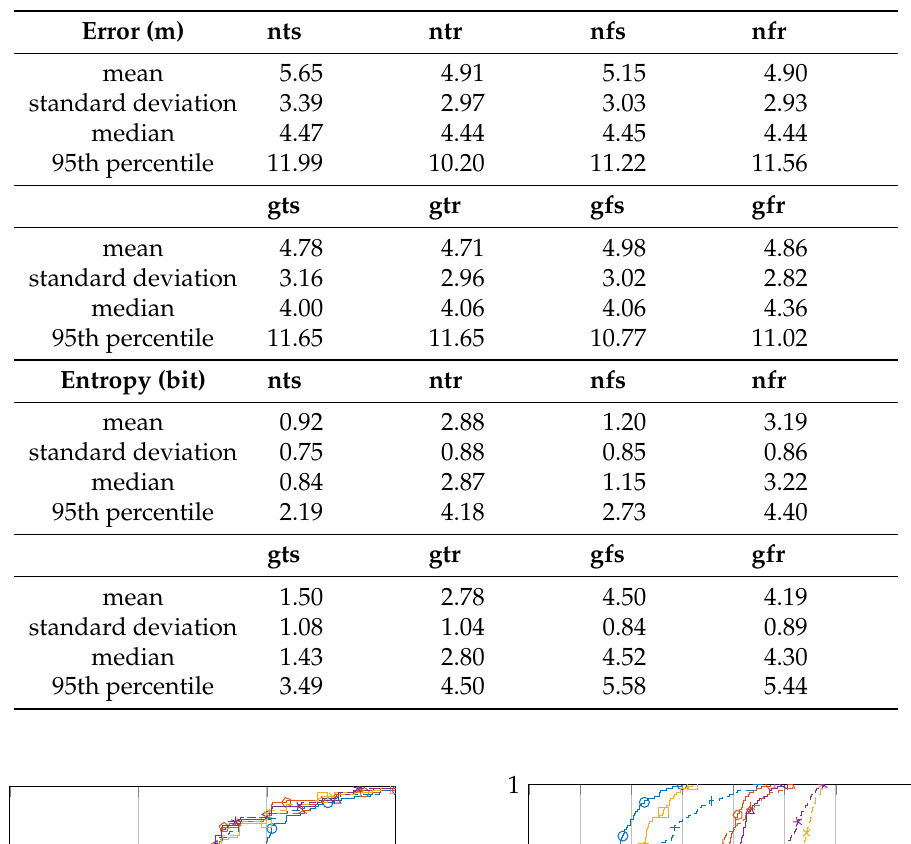
Table 3. EVARILOS summarizing table. The column labels refer to using the normal sensor model (n) or using the convolution sensor model (g), using the trained σ (t) or using the fixed σ (f) and using a single reference location for training (s) or using a region of reference locations for training (r).